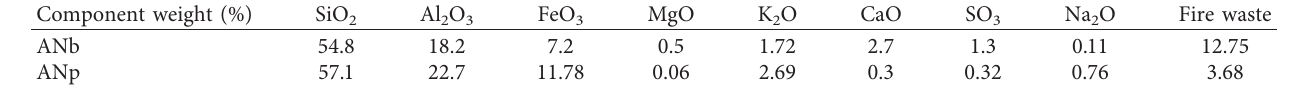
Table 4: Chemical composition of raw and purified clays of Jebel Louka.